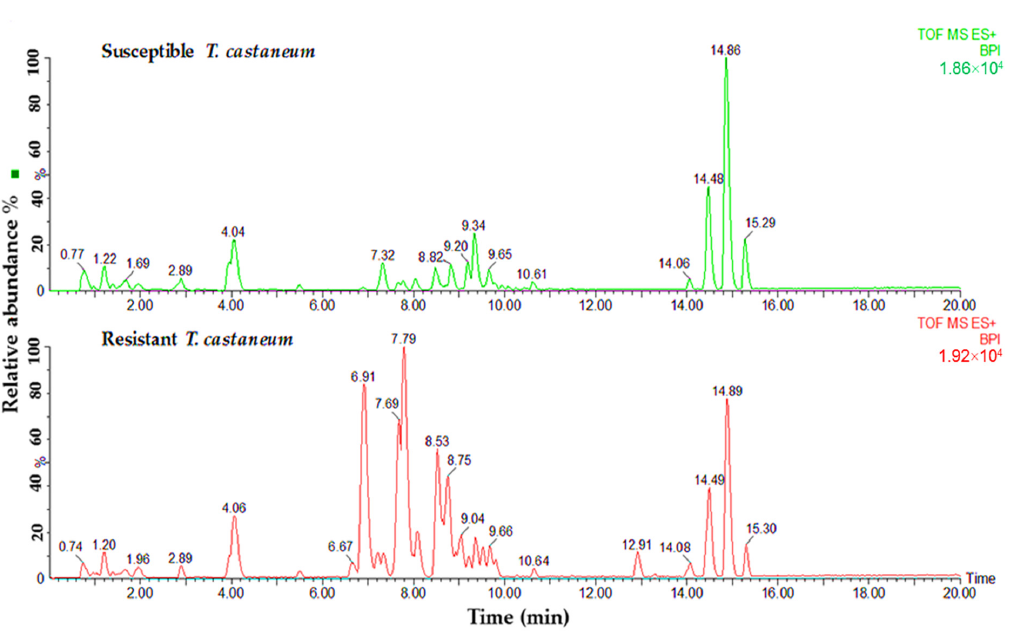
Figure 2. Base peak intensity (BPI) chromatograms show the differences in the lipid content obtained from susceptible (green) and resistant (red) strains of T. castaneum .